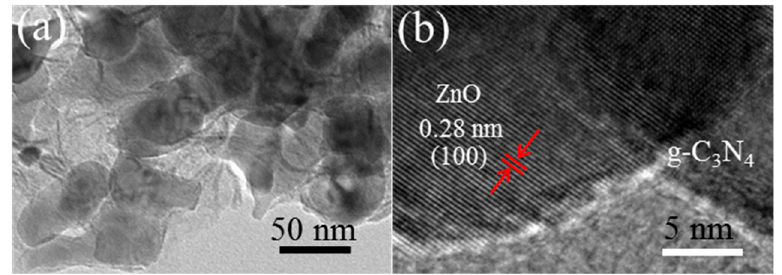
Figure 6. ( a )TEM and ( b ) HRTEM images of CNZO-8. Figure 6. ( a ) TEM and ( b ) HRTEM images of CNZO-8.